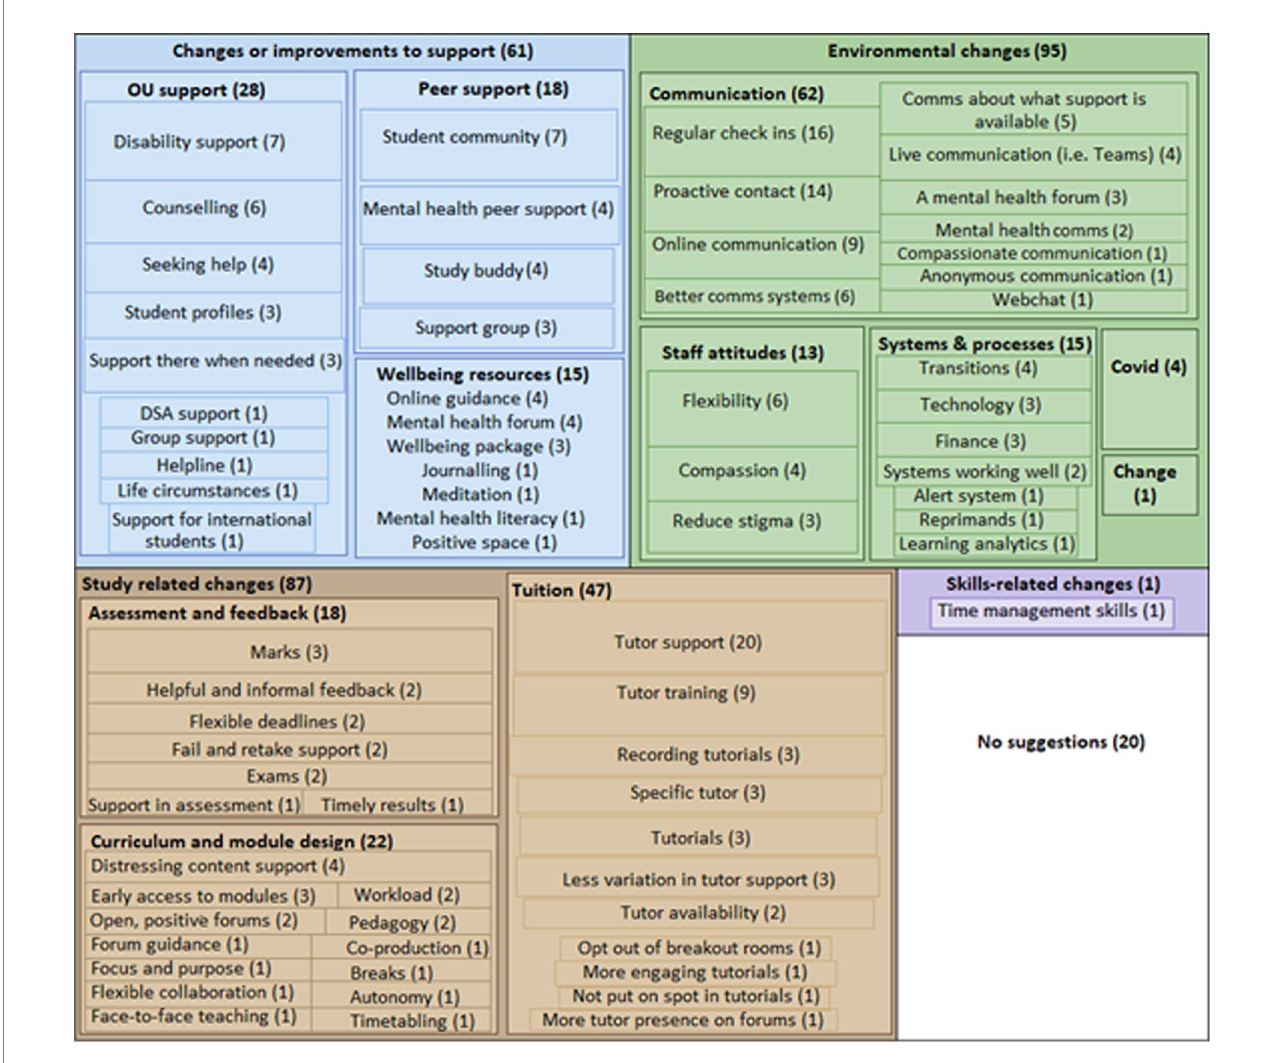
FIGURE 5 Suggestions for changes to university environments, study support and study practices to enhance student